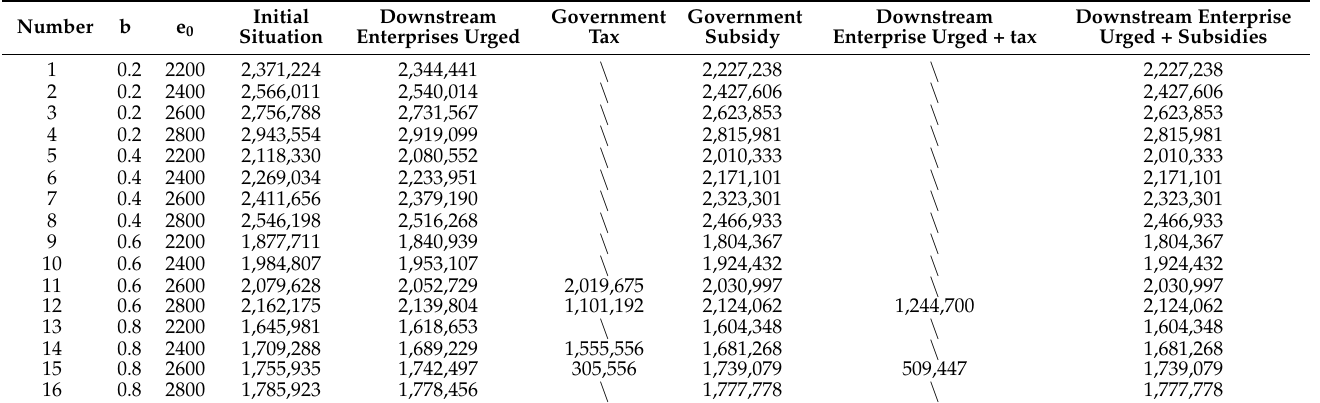
Table 4. The total negative impact of the supplier’s production on the environment.